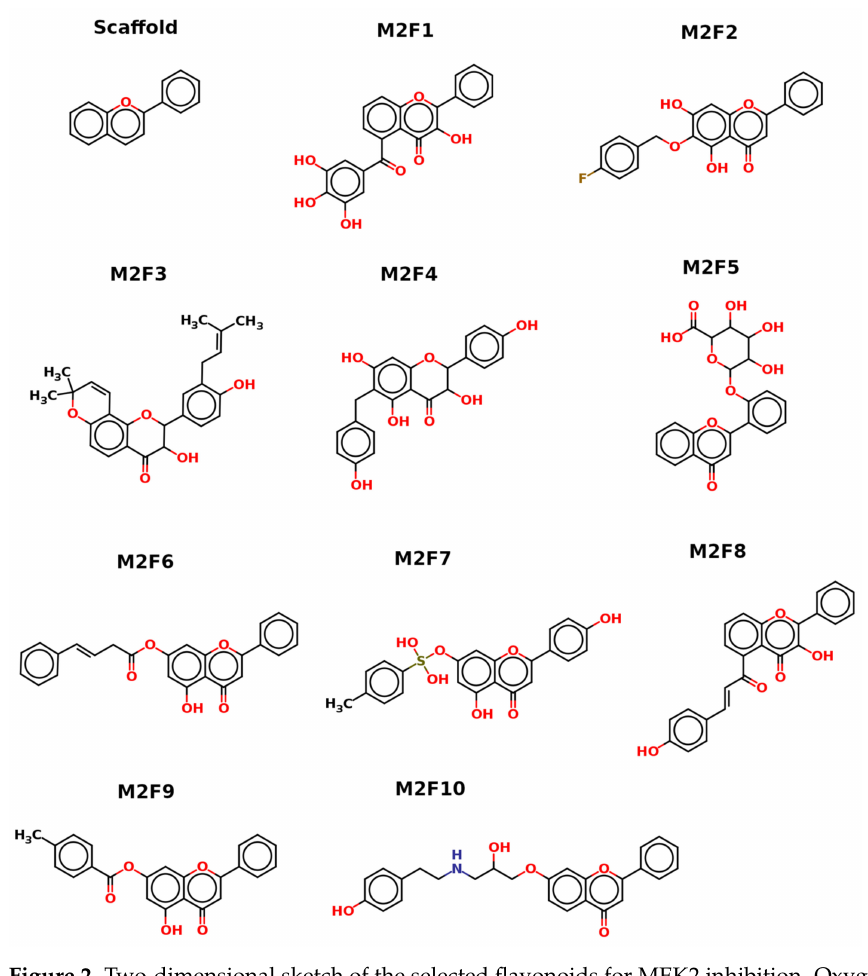
Figure 2. Two-dimensional sketch of the selected flavonoids for MEK2 inhibition. Oxygen (O), nitro- gen (N), and sulfur (S) with their balancing hydrogens are shown as red, blue, and green, respectively.